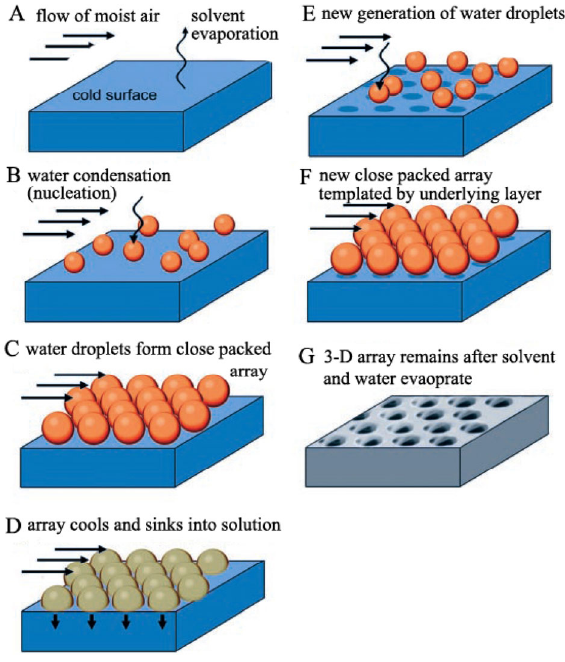
Figure 5. The BF method pore formation process [44].